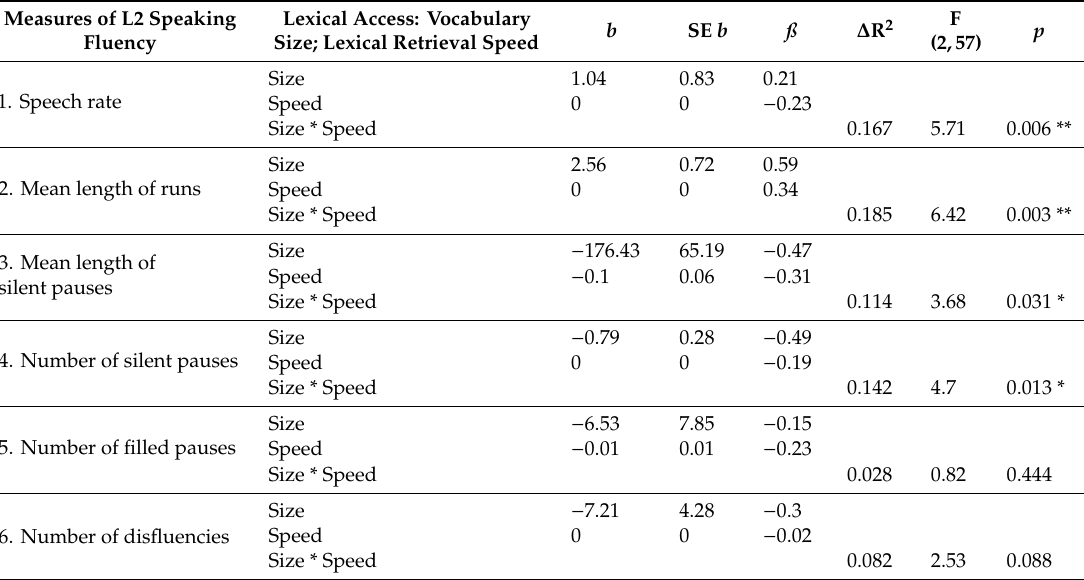
Table 4. Prediction of L2 speaking fluency by lexical access.